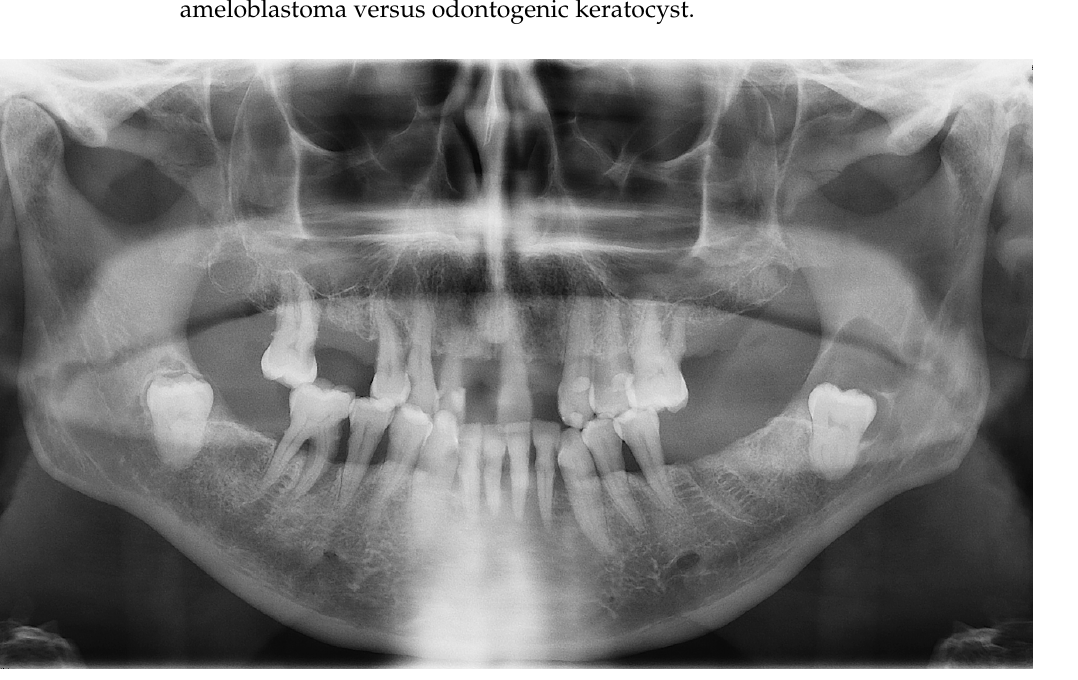
Figure 10. OPG X-ray of case #4.